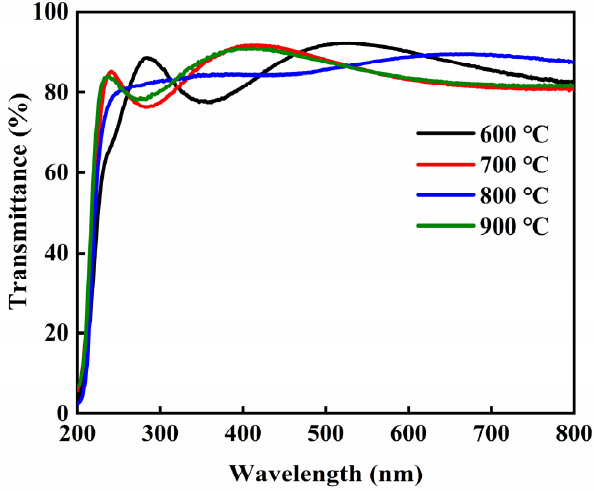
Figure 5. Transmittance profiles of AZO films at different annealing temperatures.